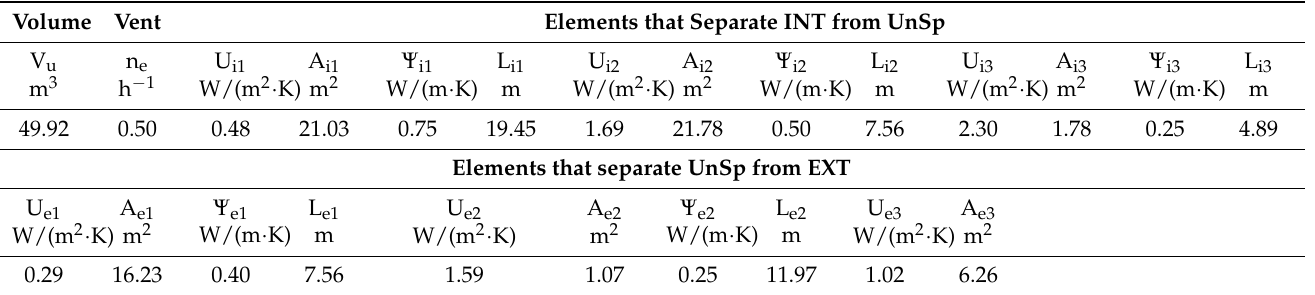
Table 16. Geometric and physical characteristics of Garage